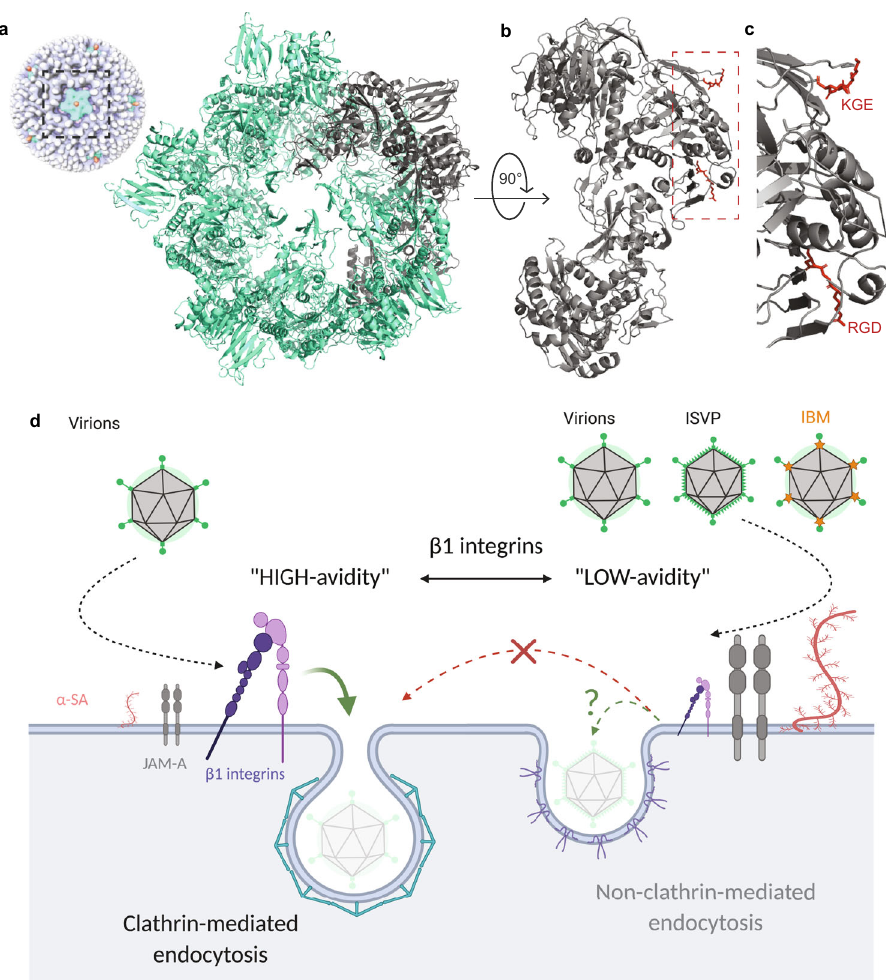
Fig. 7 Integrin interaction with λ 2 reovirus outer capsid protein mediates clathrin-recruitment for entry into host cells. a Crystal structure of the λ 2 turret (pentamer, about 120 Å diameter and 80 Å tall), viewed from the top. Cryo-electron microscopy reconstruction of the virion is shown on the side 8,55 . The fi ve elongated λ 2 monomers, four shown in green and one in gray, wrap around the other surface, with their long axes about 45° to the radial direction. b The λ 2 monomer, viewed from the side (the gray monomer in a ). β 1 integrin binding sequences, RGD and KGE, are highlighted as red sticks. c Zoom-in on